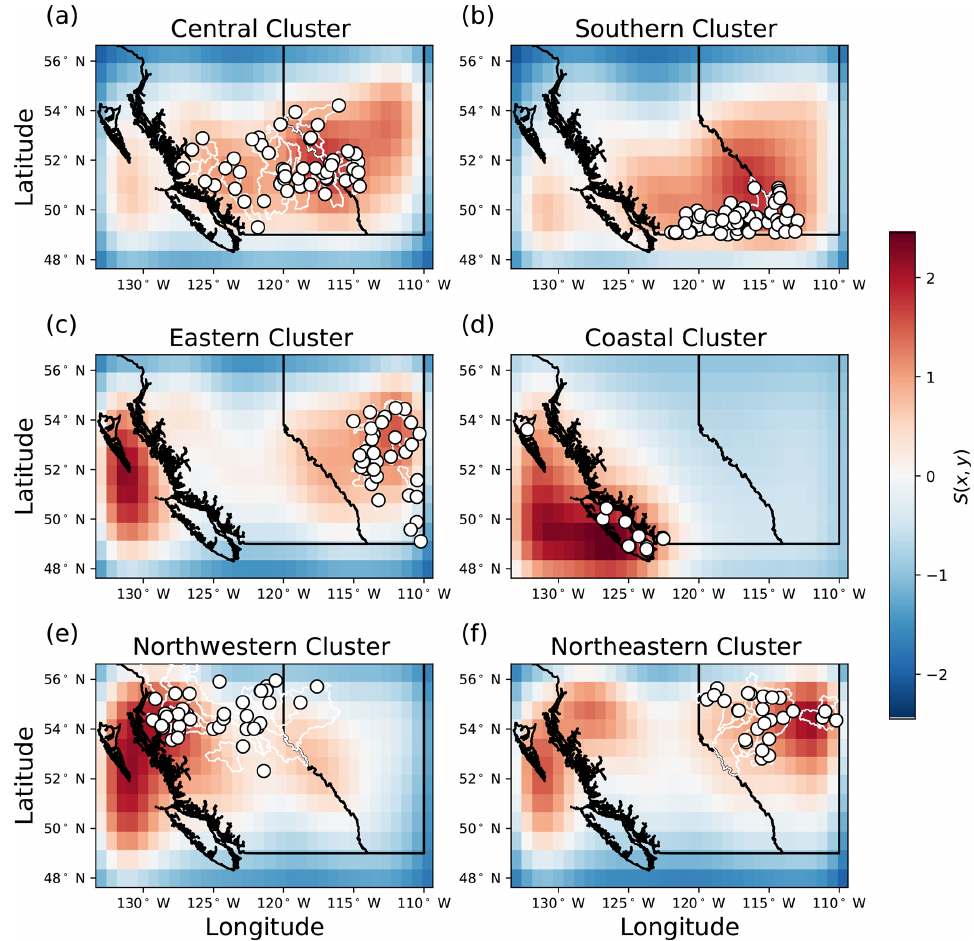
Figure 7. Ensemble mean sensitivity maps. For each cluster, the mean sensitivity map S(x,y) is calculated across all stations and all days in the test period. The (a) central, (b) southern, (d) coastal, and (e) northwestern clusters are generally most sensitive in the areas nearest the basins where streamflow is being predicted. The (c) eastern and (f) northeastern clusters are most sensitive to perturbations both near the stations being predicted and further away along the west